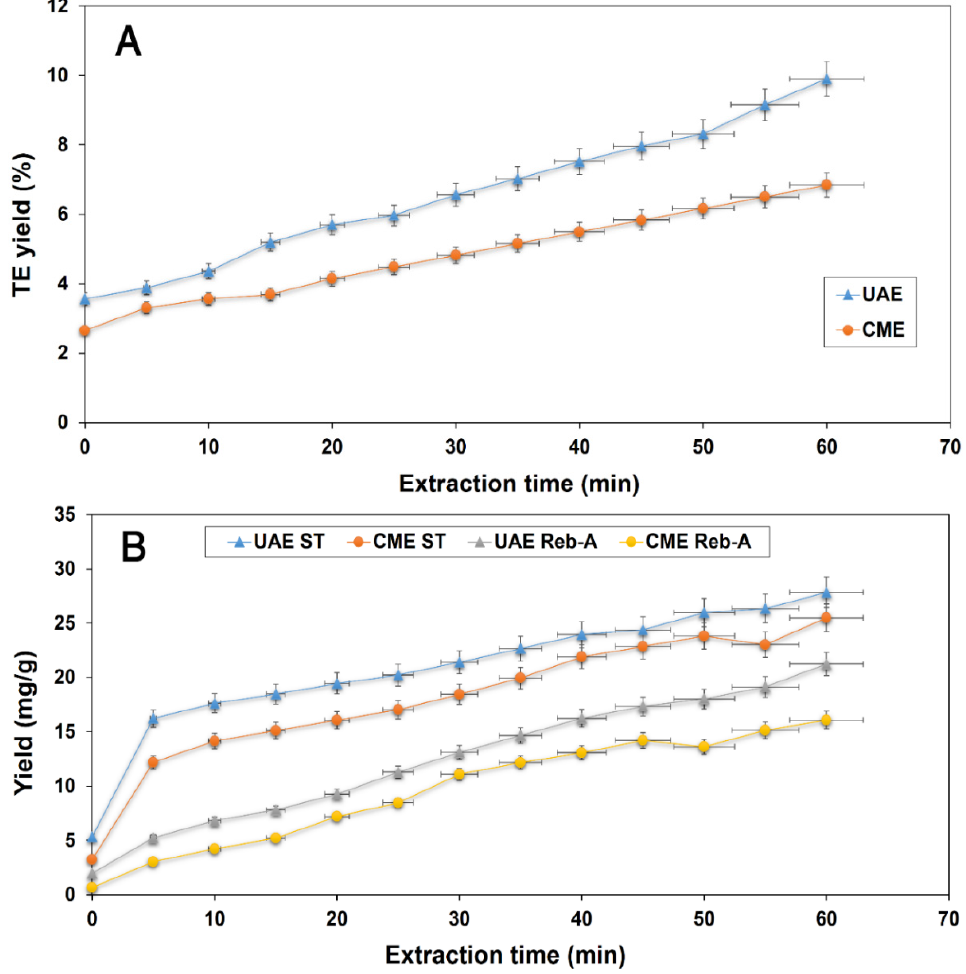
Figure 7. UAE comparison at optimized extraction conditions ( X 1 : 75% ethanol concentration, X 2 : 43 min sonication time and X 3 : 0.28 g·mL − 1 leaf-to-solvent ratio) and CME for: TEY (%) ( A ), ST, and Reb − A yields (mg/g) ( B ).